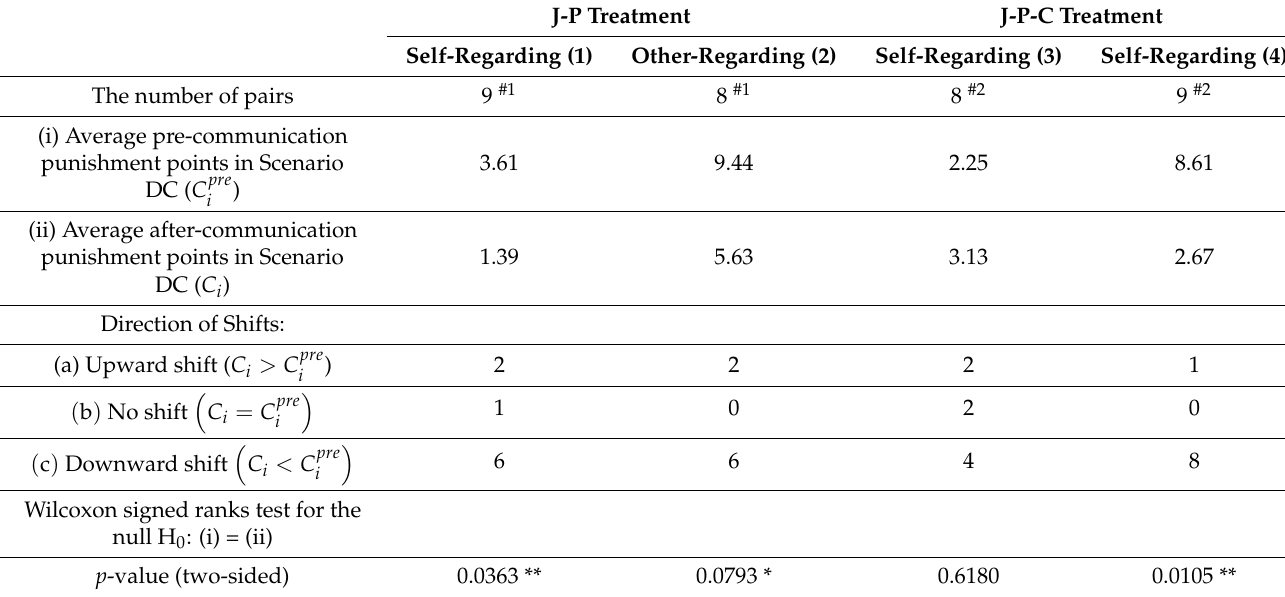
Table 2. Shifts in the Third-Party Pairs’ Willingness to Punish through Communication. J-P